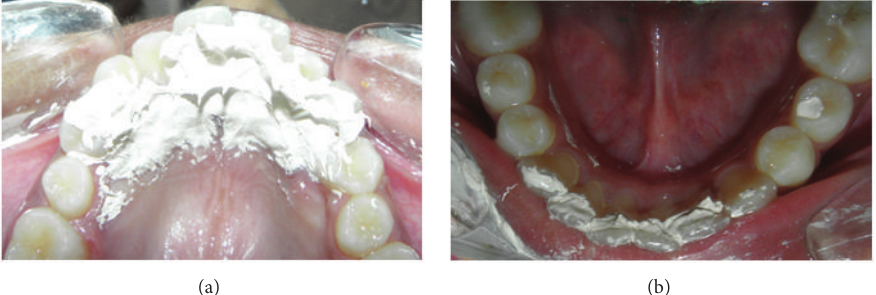
Figure 3: Pretreatment palatographic analysis showing impression material smeared over the maxillary and mandibular anteriors indicating abnormal tongue posture during swallowing.